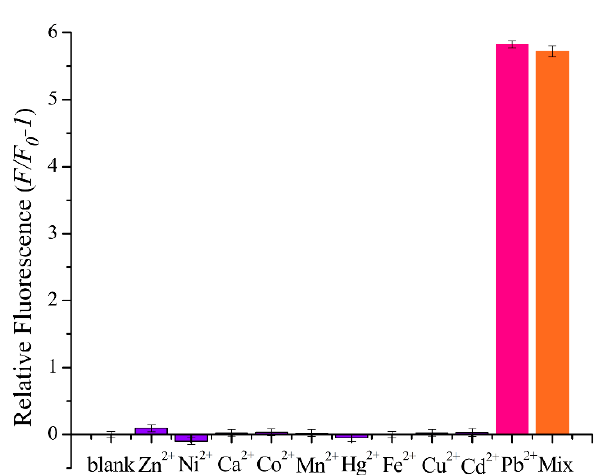
Figure 5. The selectivity of DNAzyme-R-PE for Pb 2 + (150 nM) over other divalent metal ions (150 nM).